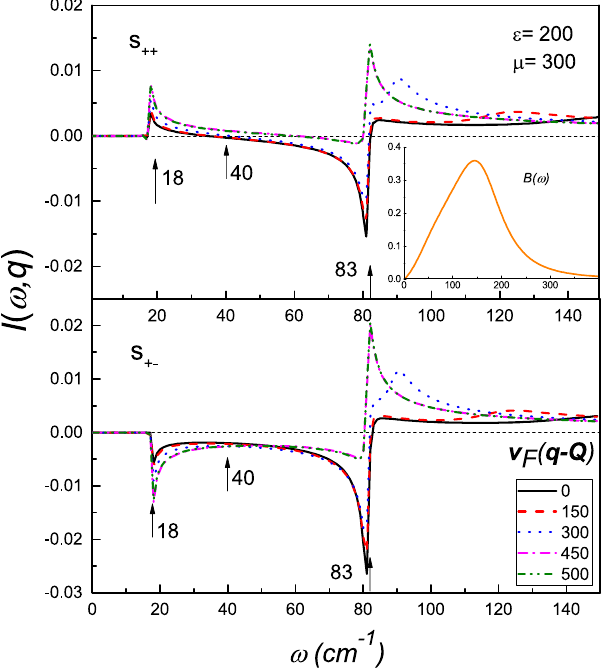
Figure 1. The QPI response function I( ω , q ) of the scattering between the electron and the hole bands, for the s ++ and s ± symmetry of the superconducting order parameter at various momentum values with parameters as, ε = 200, δμ = 300 and φ = 0 with β = − 1 at T = 1 cm − 1 . The transition temperature is T upper panel: the spectral function of the electron-bosonic interaction B (Ω).